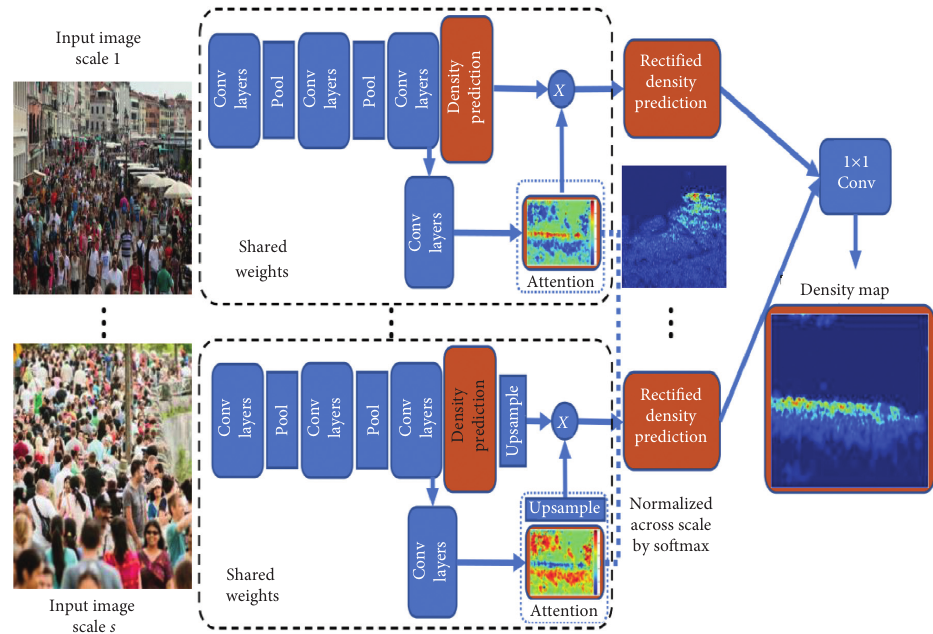
Figure 2: Experimental design framework for human flow density